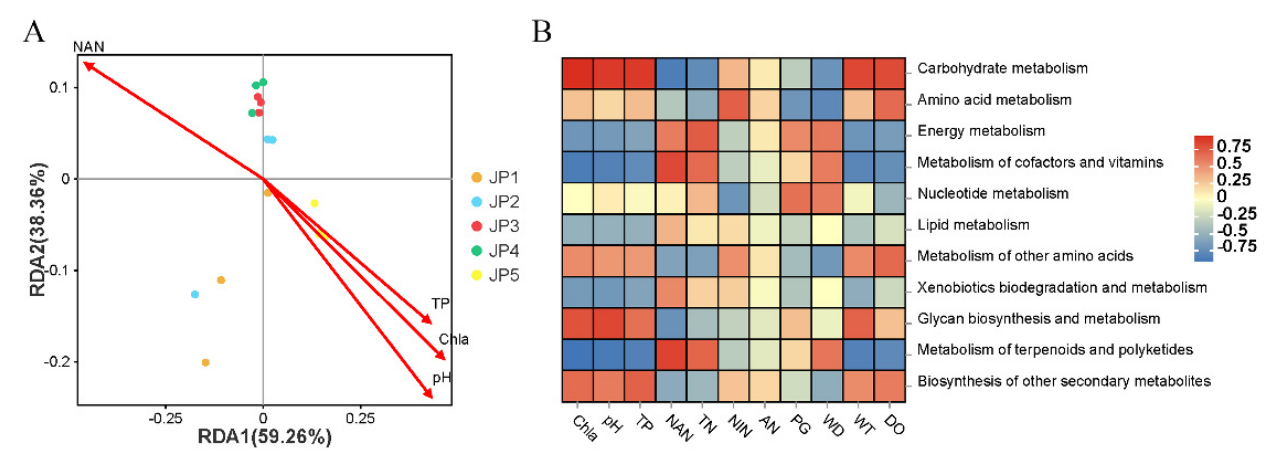
Figure 7. Correlation between physicochemical factors and microbial metabolism functions. ( A ) Redundancy analysis (RDA) depicted the relationship between the top four environmental indicators and the level B microbial metabolism functions among five groups. ( B ) Correlation heatmap between level B microbial metabolism functions and all physicochemical factors. Statistical analyses of correlations were performed using Pearson correlation analysis.